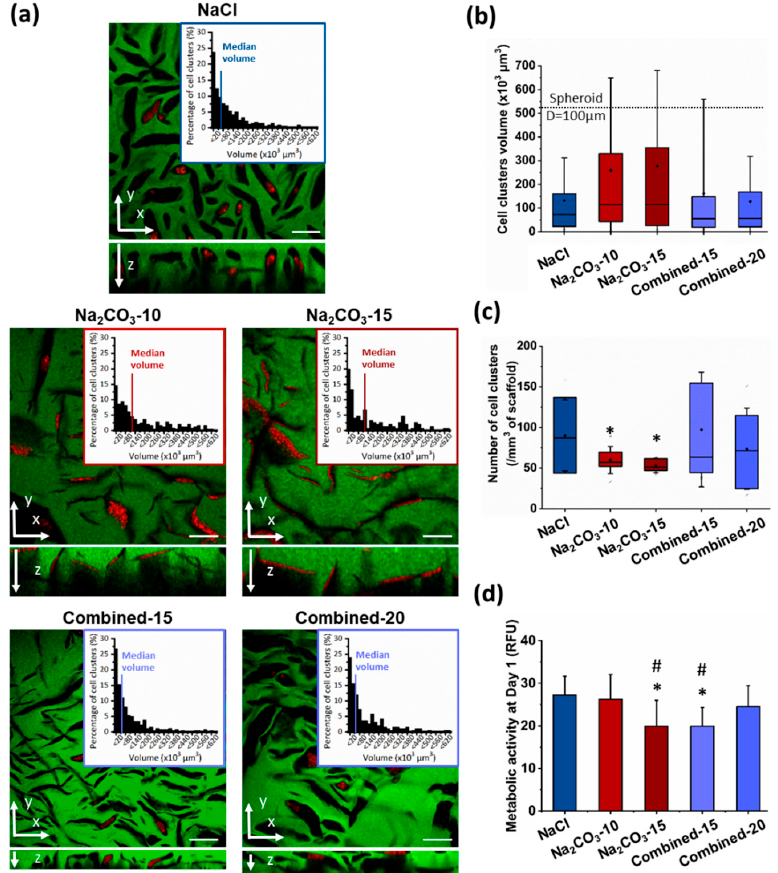
Figure 3. HepG2 cell clusters size and conformation in 3D sca ff olds after seven days of culture. ( a ) Confocal image of the interior of sca ff olds formed using NaCl (top panel), Na 2 CO 3 (middle panel) or a combination of both porogens (bottom panel). Sca ff olds were observed here in green due to 1% Dextran-FITC in the formulations. Cell clusters are shown using phalloidin-TRITC staining. Volume distribution of cell clusters (top right panels) formed within the sca ff olds were determined using a 3D semi-automatic analysis using Imaris software. Scale bar: 200 µ m. ( b , c ) Distribution of cell clusters volumes ( b ) and number of cell clusters per mm 3 of sca ff old ( c ) represented as box plot using median and 25–75 percentile. Mean volume is represented as a diamond-shape dot, error bars represent standard deviation. ( d ) Metabolic activity analysed at day one after seeding. Statistical analysis was performed using student t -test. * represent statistical di ff erence towards NaCl sca ff olds. # represent statistical di ff erence ( p < 0.05) towards Na 2 CO 3 -10 sca ff olds. All other di ff erences were not